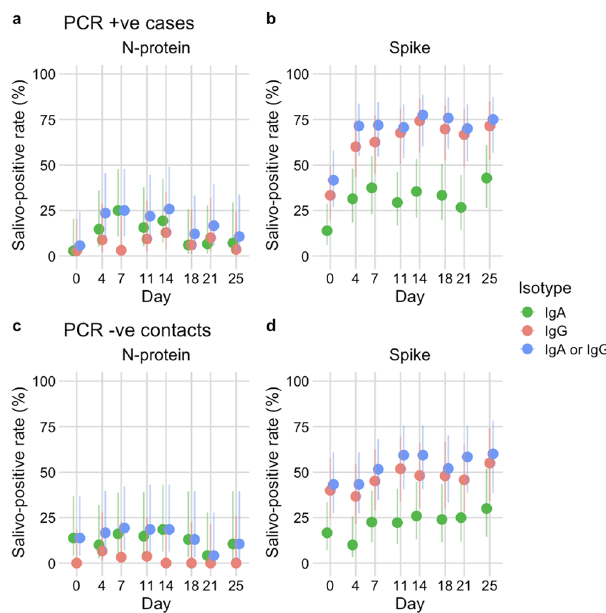
Fig. 5 Application of assays to household outbreaks. a - d Salivo-positive rate for 20 households with SARS-CoV-2 outbreaks ( N = 20 index cases and 51 contacts) based on detection of anti-nucleocapsid (N-protein) or anti-spike, IgA (green points), IgG (red points), IgA or IgG (blue points). Salivo-conversion for household members with PCR-con fi rmed infection ( N = 31) during the study is shown in ( a , b ), household members remaining PCR negative ( N = 36) are shown in ( c , d ). Error bars represent 95% con fi dence intervals for a single proportion (Wilson method).